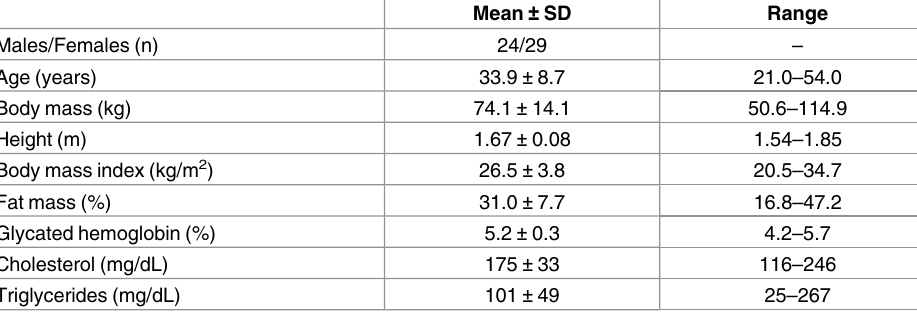
Table 1. Characteristics of